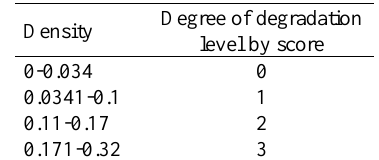
Table 1. The number of winter and spring camp locations per 1.0 km 2 .